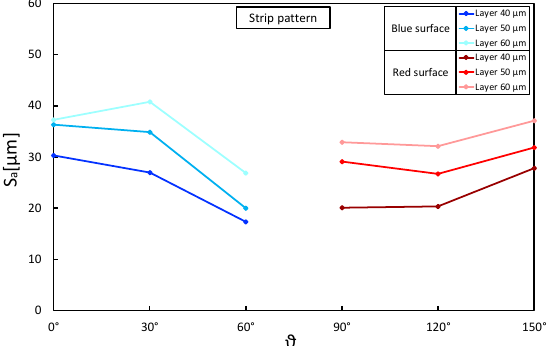
Figure 8. S a as a function of layer thickness ( t ) and building angle ( θ ): strip laser